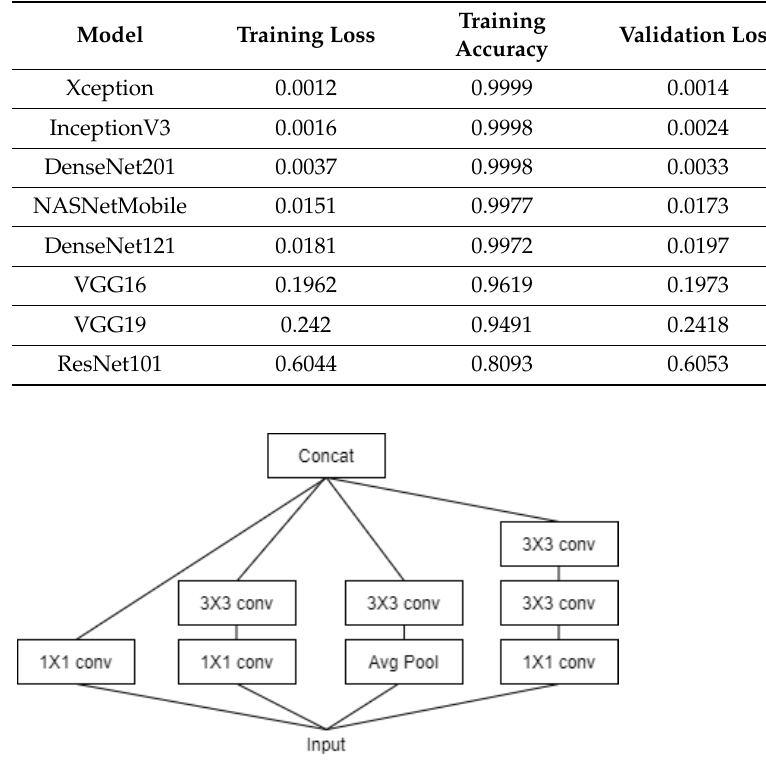
Table 2. Model Performance comparison for transfer learning from ULTT datasets.